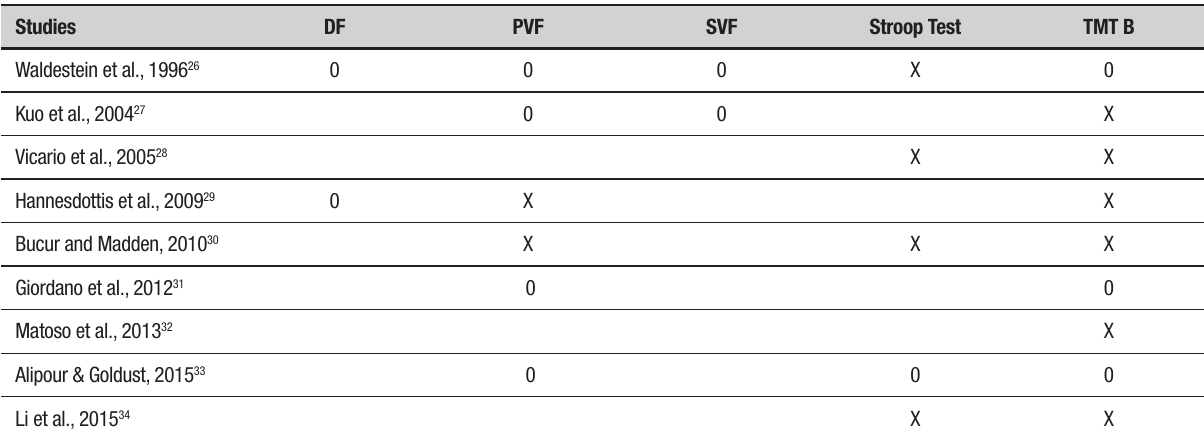
Table 5. Summary of impaired tests among patients with SAH in cross-sectional studies.